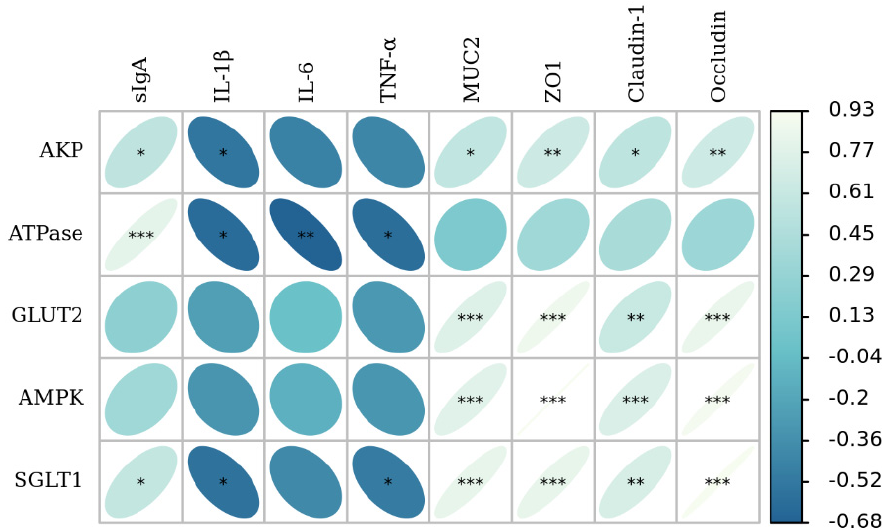
Figure 5. Correlation analysis between intestinal barrier function and intestinal glucose absorption capacity. * p < 0.05, ** p < 0.01, *** p < 0.001.